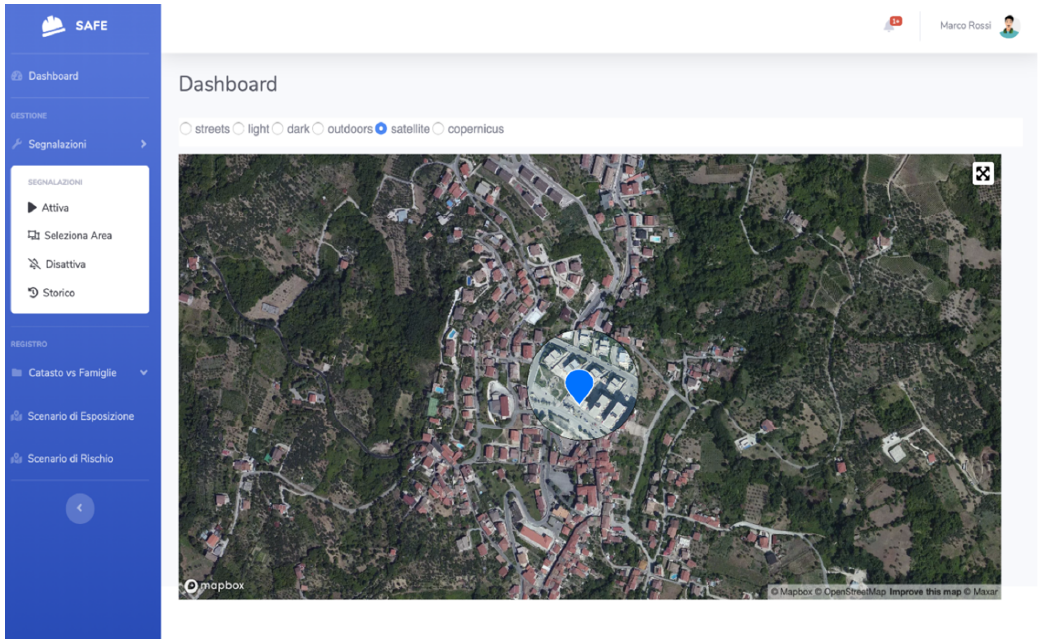
Figure 12. Visualizing the location of a new user.